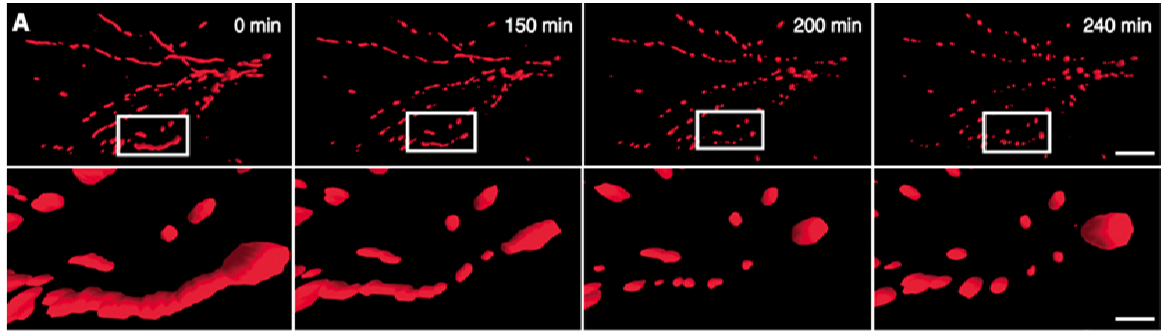
Figure 4. NO • triggers mitochondrial fission. ( A ) 3D time-lapse microscopy of mitochondria undergoing fission in a dendritic arbor of a neuron. Neurons were transfected with Mito-DsRed2, pretreated with the pan-caspase inhibitor zVAD-fmk methyl ester (100 M), and exposed to SNOC (200 M). Images were 3D iso-surface rendered. Frames depict representative time points of the movie demonstrating mitochondrial fragmentation within 3 h of NO • exposure (upper panels; scale bar, 15 µm) and closeup views (lower panels; scale bar = 3